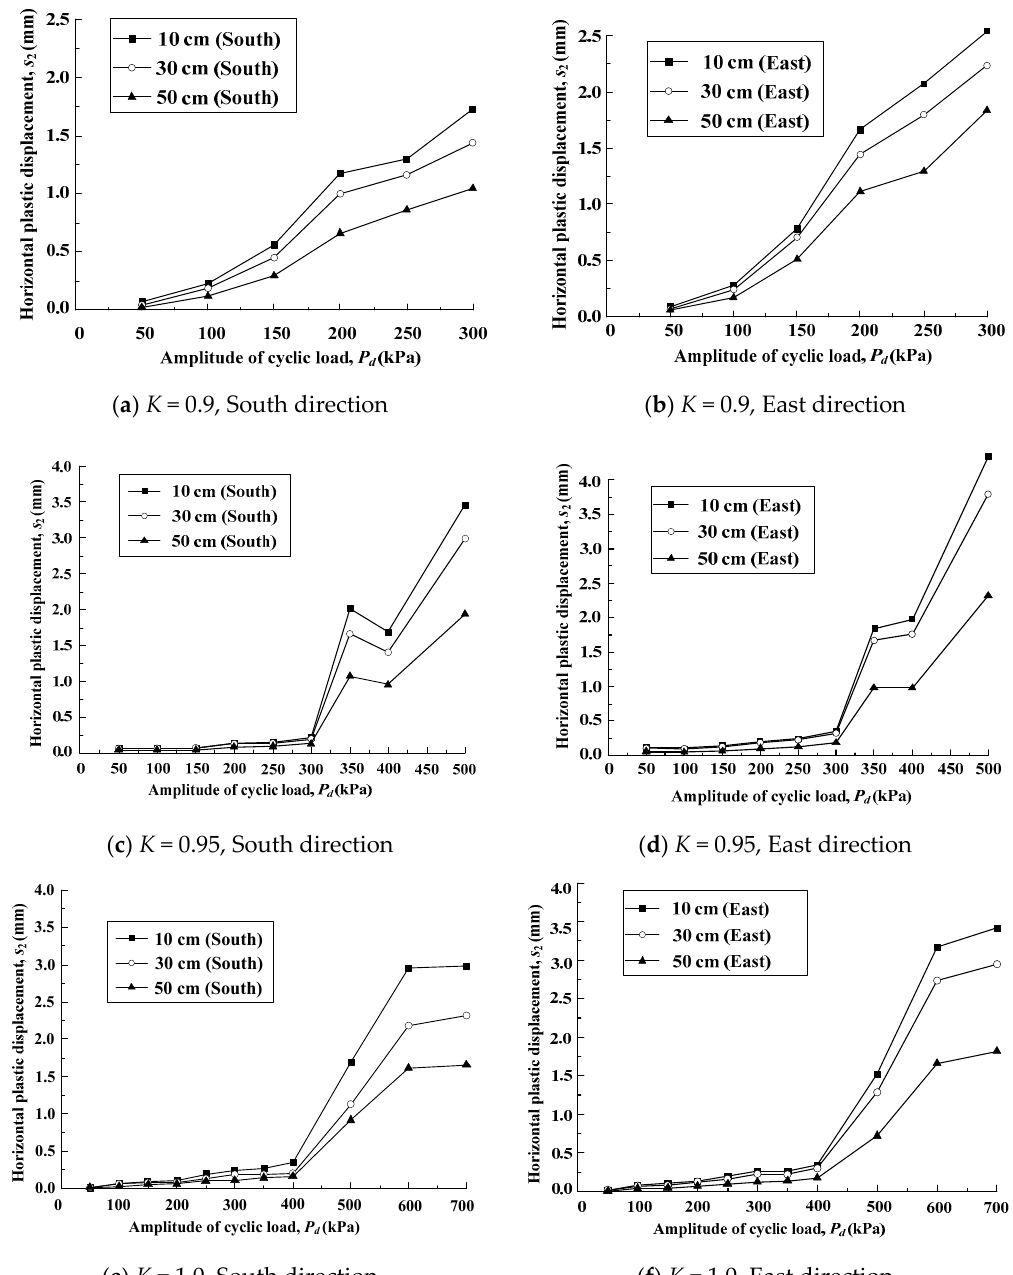
Figure 10. The relationship between horizontal displacement and cyclic amplitude.